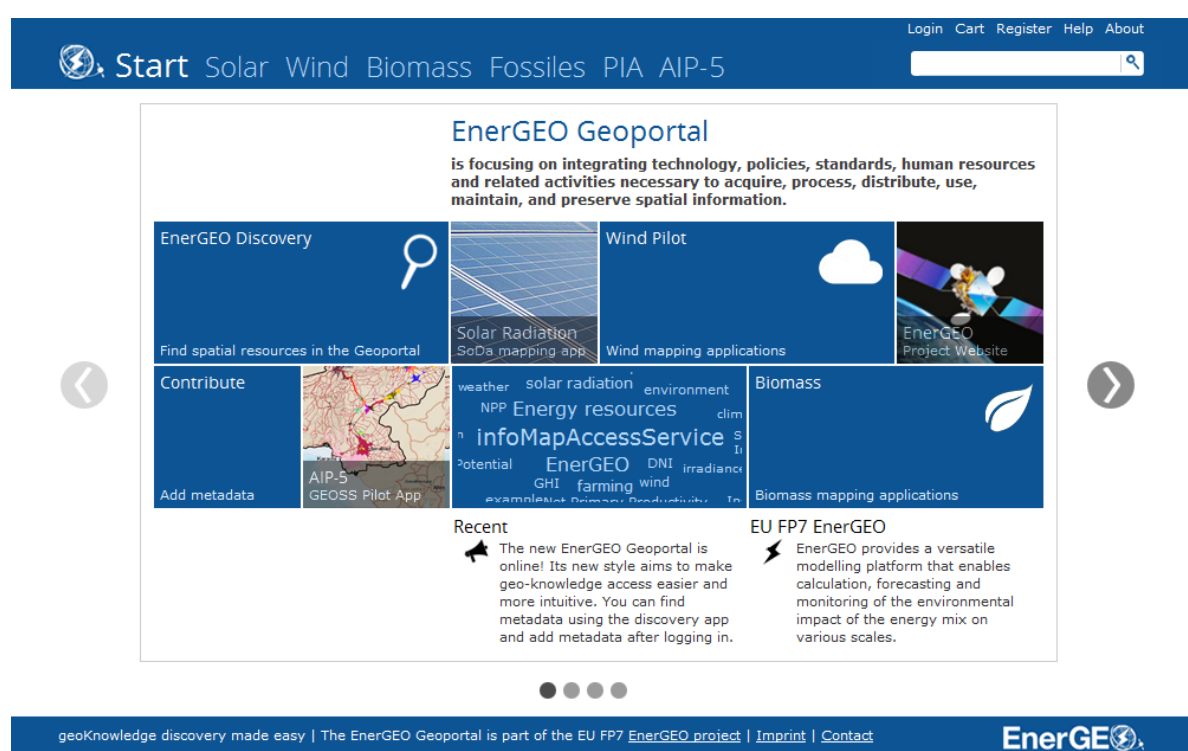
Figure 2. EnerGEO